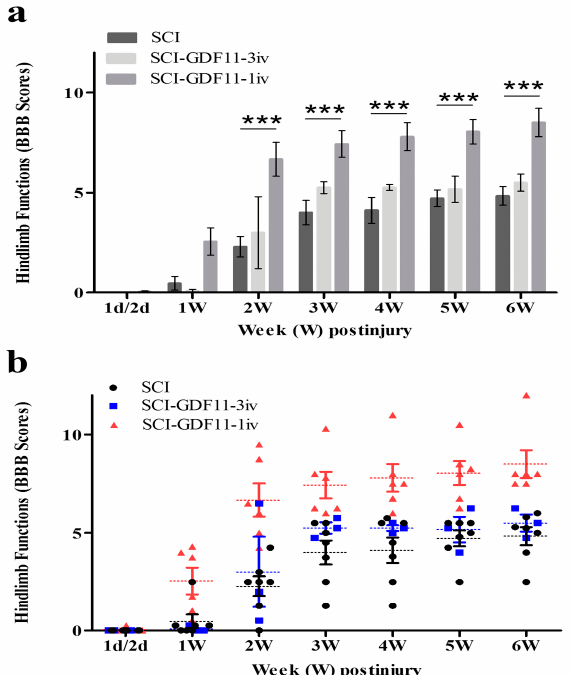
Figure 7. Time course of hindlimb locomotor recovery in rats receiving saline or GDF11 after contusive injury. ( a ) Data are plotted as a bar chart. ( b ) Data are plotted with individual data points. Within 30 min of injury, SCI rats were injected with saline or GDF11 through the tail vein once (24 µ g/rat) or for 3 consecutive days (8 µ g/rat/injection, daily). Locomotor recovery of the SCI rats was evaluated over a 6-week period, using a 21-point scale (Basso–Beattie–Bresnahan (BBB) locomotor rating scale). The hindlimb recovery of the animals was assessed in a double-blind manner. The results are reported as mean ± SEM from 7, 3, and 6 rats for SCI, SCI-GDF11-3iv, and SCI-GDF11-1iv, respectively. Statistical significance was evaluated using two-way ANOVA and Bonferroni’s t -test. *** p <